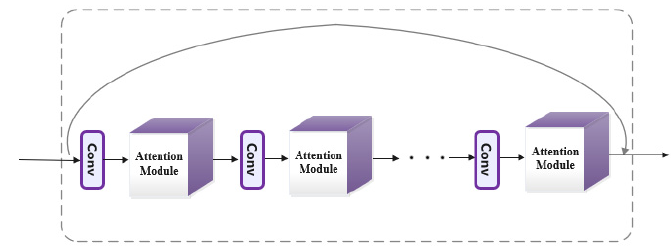
Figure 7. The architecture of the SRCAN module.